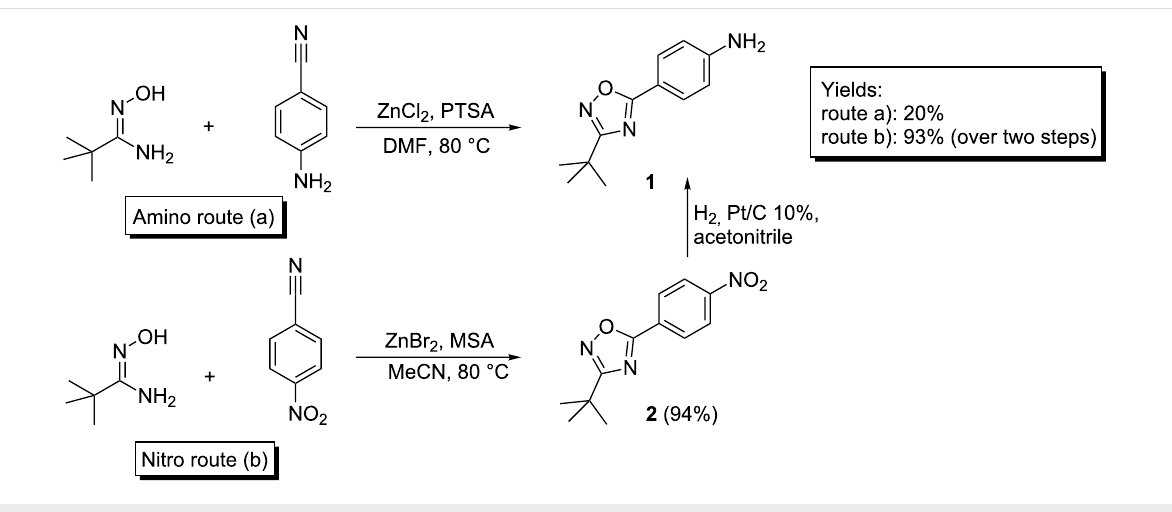
Scheme 3: One-pot synthesis of 4-(3- tert -butyl-1,2,4-oxadiazol-5-yl)aniline ( 1 ) by using the 1,3-dipolar cycloaddition